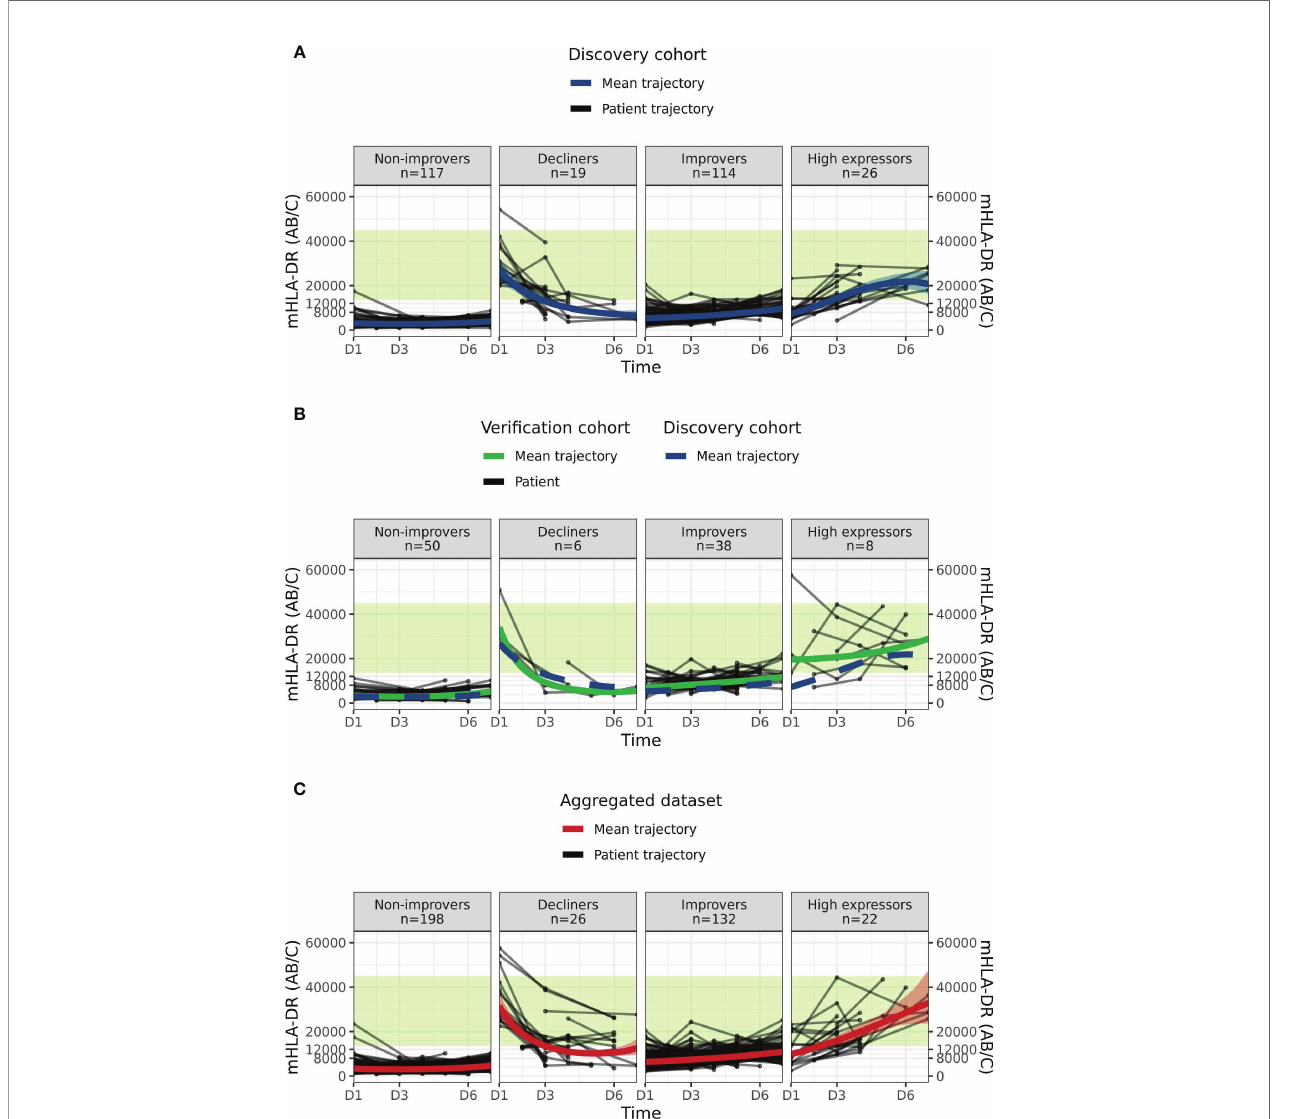
FIGURE 1 | Sepsis mHLA-DR trajectory endotypes. (A) Discovery dataset: “ Non-improvers ” , “ Decliners ” , “ Improvers ” and “ High expressors ” endotypes from KmL clustering method are represented in each panel. Black lines and dots correspond to individual patients mHLA-DR trajectories and values at the sampling time point, respectively. Blue line and blue band represent the mean endotype trajectory from a mixed effect model and the associated 95% con fi dence interval. The green area represents Healthy Volunteers reference interval, as de fi ned in (14). (B) Veri fi cation dataset “ Non-improvers ” , “ Decliners ” , “ Improvers ” and “ High expressors ” endotypes from a clustering de novo with KmL method are represented in each panel. Black lines and points respectively correspond to veri fi cation cohort ’ s patients mHLA-DR trajectory and their sampling time point. The green area represents Healthy Volunteers reference interval, has de fi ned in (14). Green solid line and blue dashed line represent the mean trajectory from a mixed effect model of veri fi cation cohort and discovery cohort, respectively. (C) Discovery and Veri fi cation cohorts were merged in an “ Aggregated dataset ” and KML unsupervised clustering was run de novo on mHLA-DR expression values. The fi gure represents patient trajectories in each panel. Black lines and points correspond to aggregated dataset patients mHLA-DR trajectory and their sampling time point, respectively. Red line and red band represent from a mixed effect model the mean endotype trajectory and the associated 95% con fi dence interval, respectively. The green area represents Healthy Volunteers reference interval, de fi ned in (14). Mean trend mHLA-DR values are reported in sTable 3